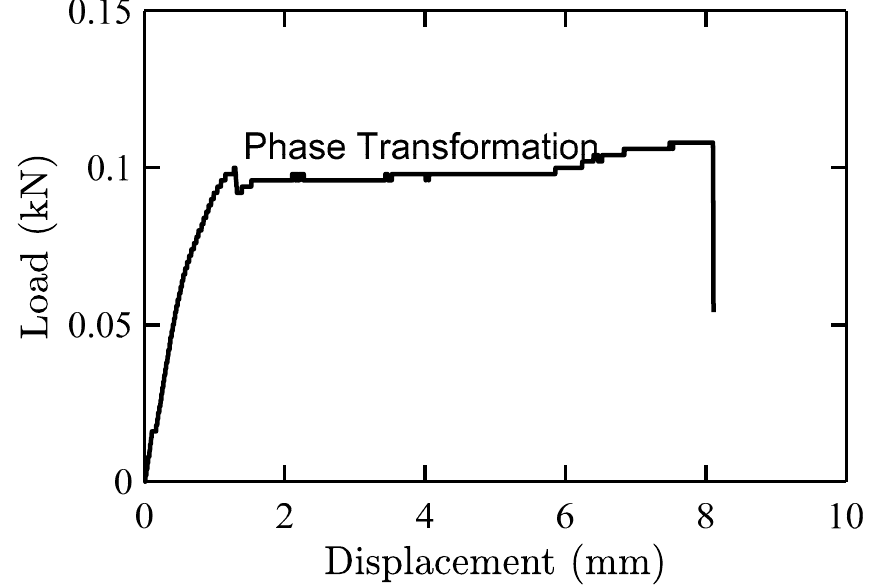
Figure 5. Load vs. displacement curve for SMA/epoxy composite specimen under the pull-out